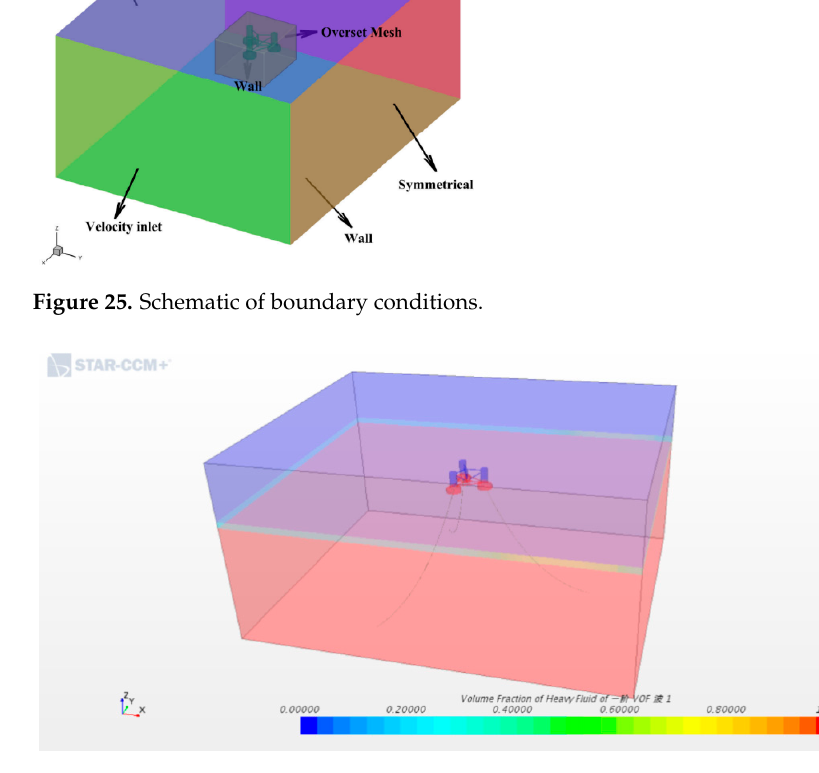
Figure 25. Schematic of boundary conditions.